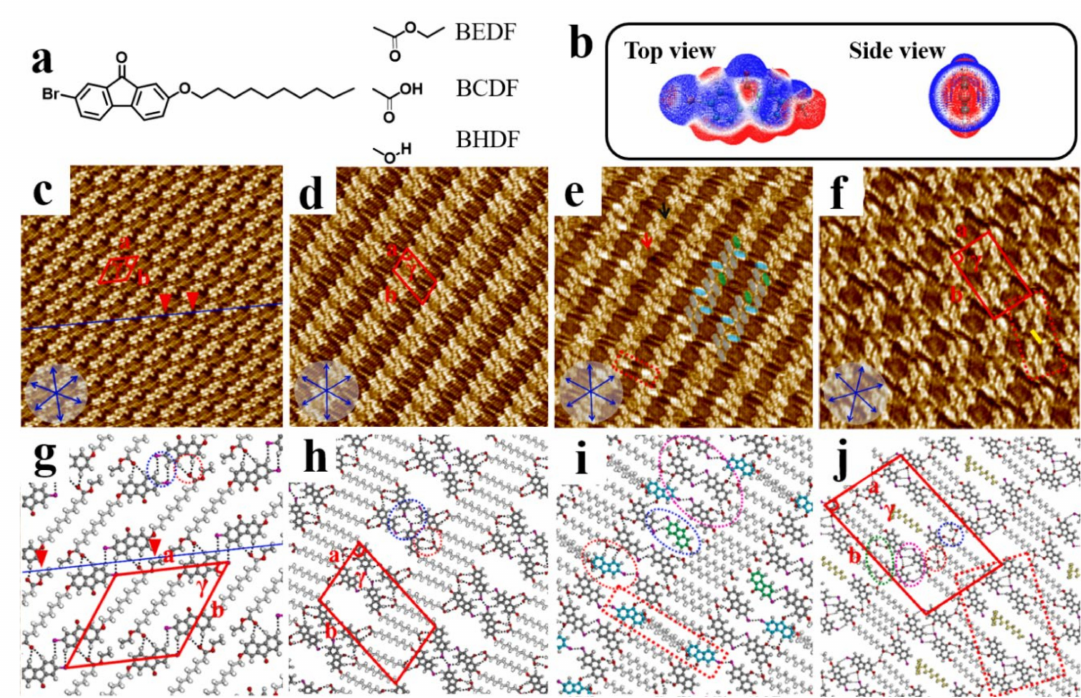
Figure 11. ( a ) Chemical structures of BEDF, BCDF, and BHDF. ( b ) Top and side views of the calculated 3D ESP map of Br substituted fluorenone core. ( c – f ) High-resolution STM images show the self-assembled dimerpattern(BEDF),tetramerpattern(BCDF),lamellarpattern(BHDF)andtheoctamerpattern(BHDF) at the 1-phenyloctane / HOPG interface, respectively. Scanning areas: 20 × 20 nm 2 . ( g – j ) Proposed molecular models of ( c – f ). Reproduced from [83] with permission from the Elsevier B.